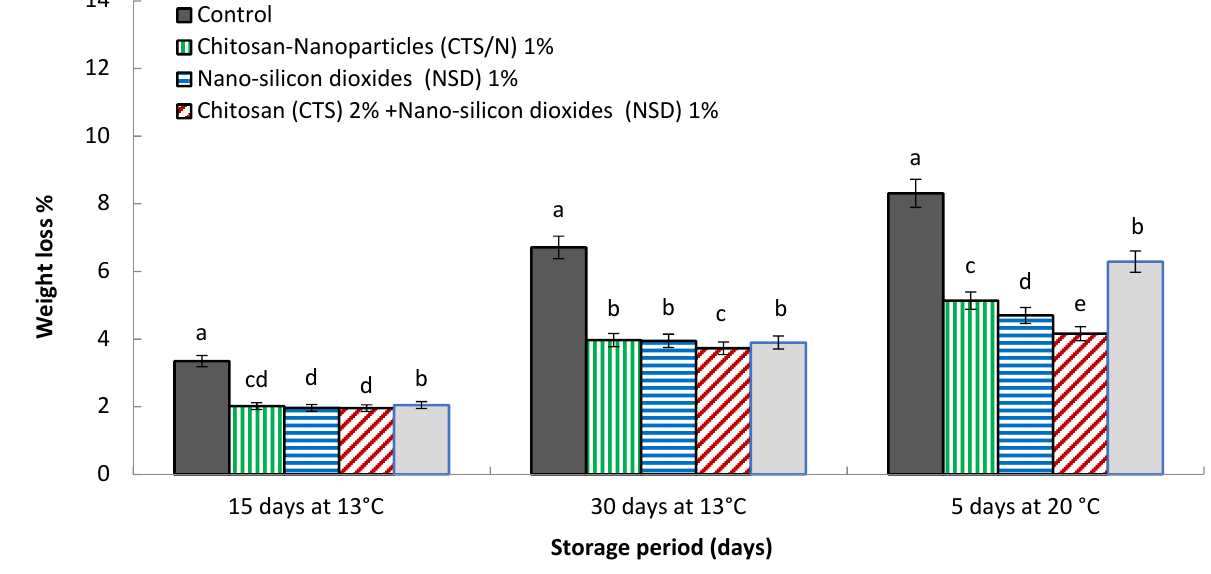
Figure 1. Weight loss percentage as a mean of ‘Tommy Atkins’ mangoes from two seasons, stored at 13 ± 1 °C and 90–95% RH for 30 days. Afterward, the fruits were stored at 20 ± 2 °C and 70–75% RH for 5 days as the marketing period. Vertical bars indicate the standard error (SE) of the mean ( n = 5). The superscript letters followed by the same letters are not significantly different according to Duncan’s multiple range test at 0.05 level.